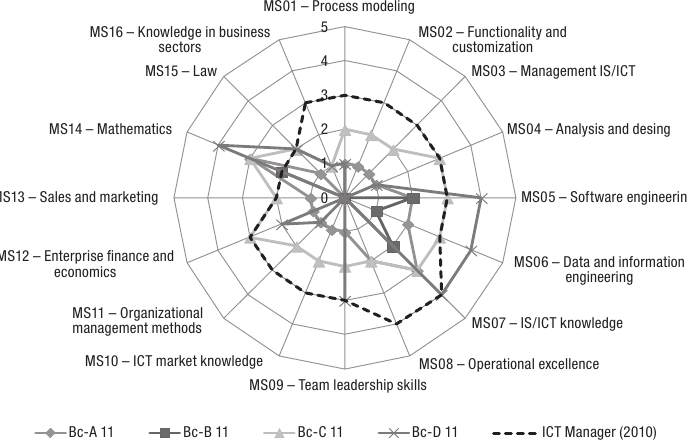
Fig. 3. Knowledge provided by bachelor’s fields of study vs demand for knowledge by economic entities for the role of ICT manager in 2010 Source: